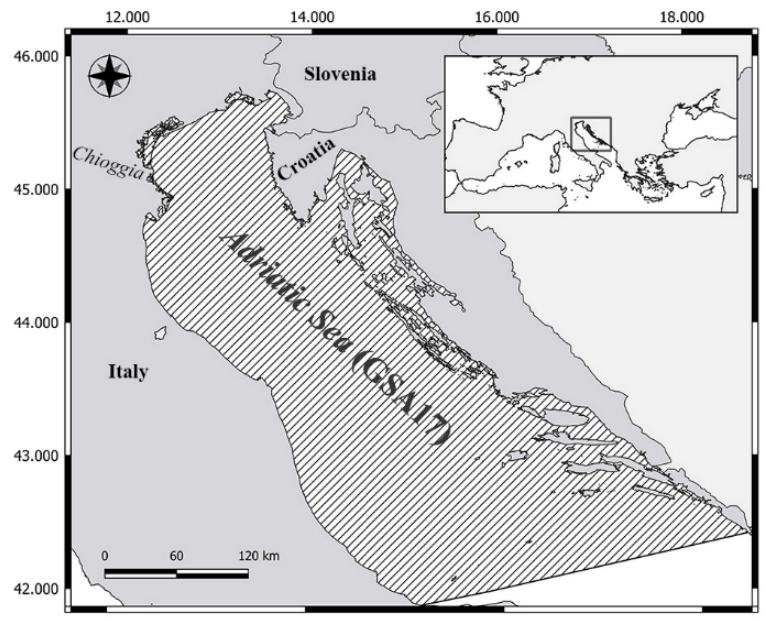
Figure 1. The study area corresponding to the Northern and Central Adriatic Sea (GSA17, Central Mediterranean Sea).